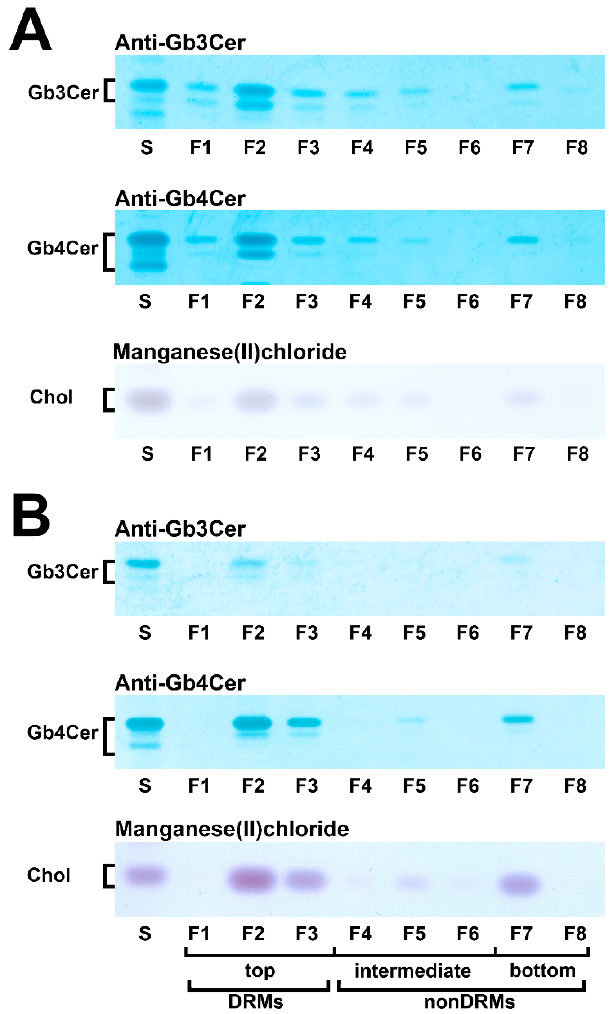
Figure 5. Distribution of Gb3Cer, Gb4Cer, and cholesterol to sucrose gradient fractions F1 to F8 prepared from pHRPTEpiCs ( A ) and pHCoEpiCs ( B ). Anti-Gb3Cer and anti-Gb4Cer antibodies